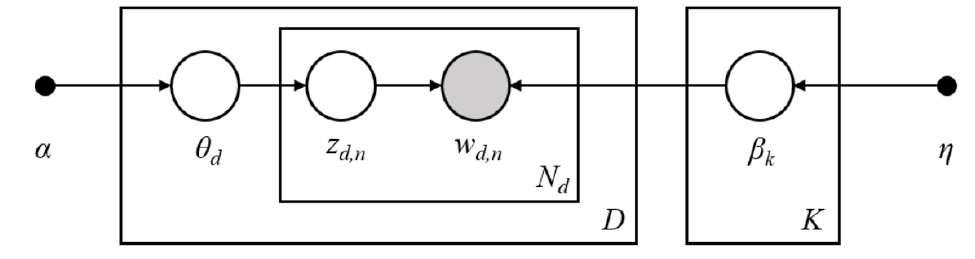
Figure 1. Textual data generative mechanism of the Topic Model